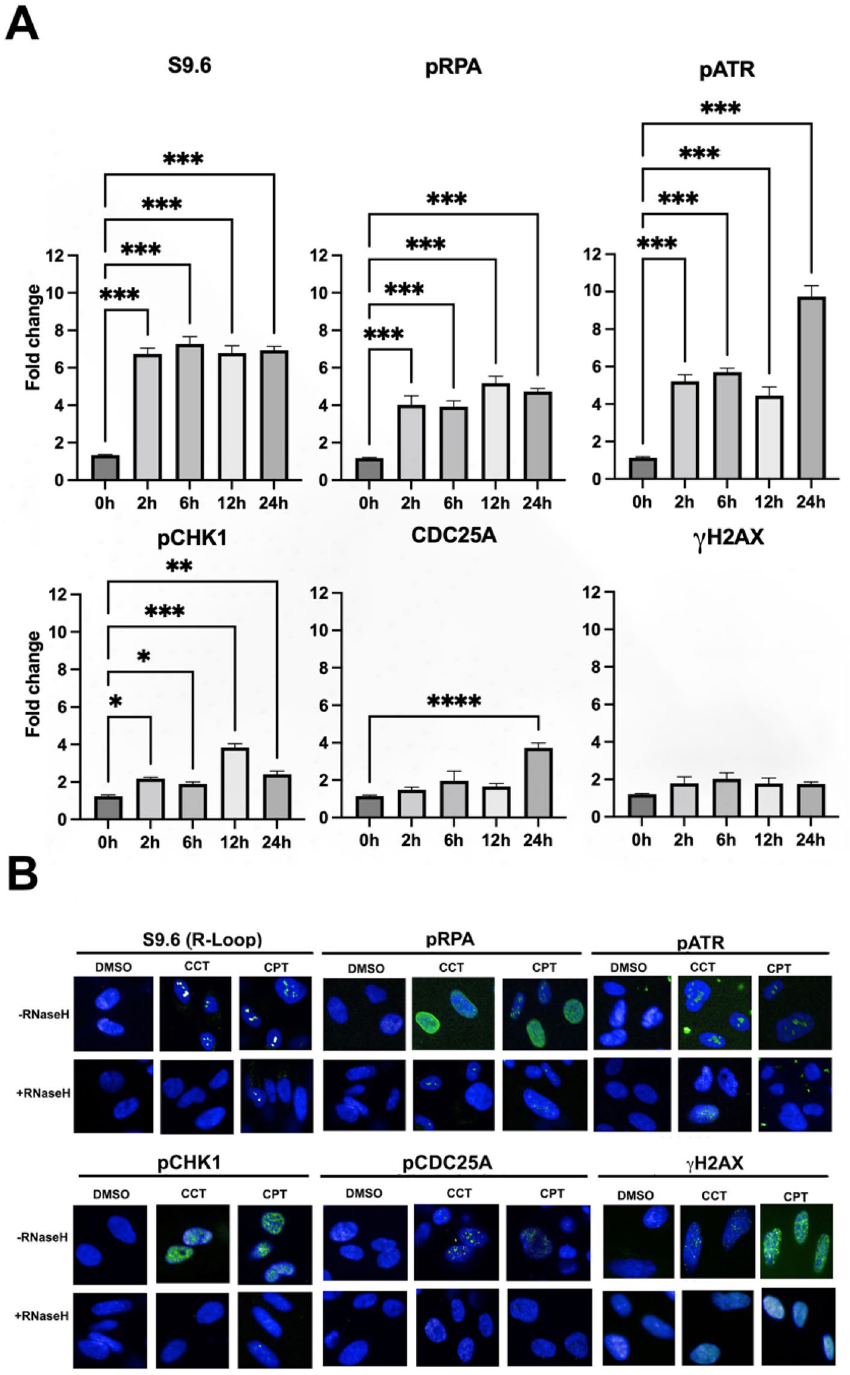
Figure 3. Mediator kinase inhibition triggers R-loop induced replication stress in UtSMCs . ( A ) Temporal kinetics of replication stress marker activation in UtSMCs following Mediator kinase inhibition. UtSMCs were treated with CCT251545 (100 nM) for the indicated time points prior to immunocytochemical analysis with antibodies specific for R-loops (S9.6), activated replication stress signaling markers [pRPA (Ser33), pATR (Ser428), pCHK1 (Ser317), pCDC25A (Ser124)] and the DNA damage marker γH2AX. Data are plotted as fold-change in antibody signal intensity relative to untreated cells (0 h). Statistical significance was calculated using One-Way ANOVA followed Tukey’s Post hoc test, **** p ≤ 0.0001, *** p < 0.001; ** p < 0.01. and * p ≤ 0.05. ( B ) Representative images of data plotted in (B). Images were captured at the peak time points for each marker. A parallel experiment was performed in UtSMCs overexpressing RNaseH (+ RNaseH). Campothecin (CPT; 10 μM) was included as positive control for R-loop induced replication stress